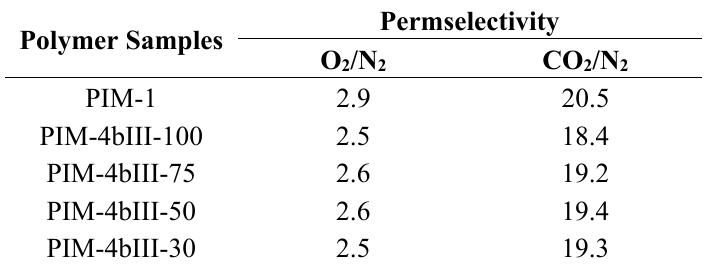
Table 3. Permselectivity of PIM-1, homopolymer and copolymers. Polymer